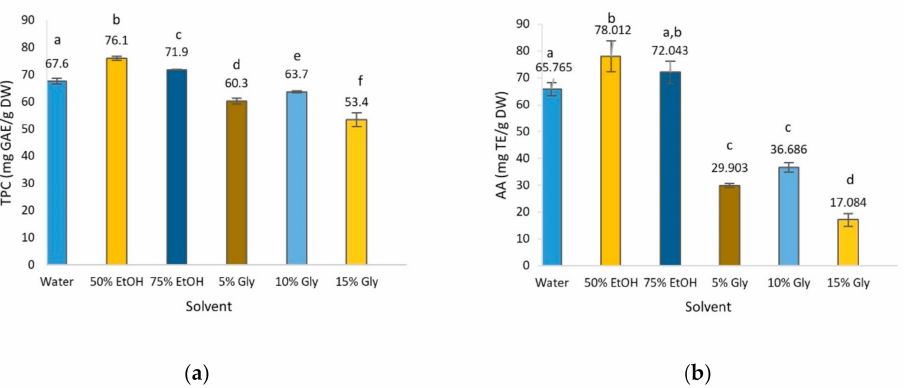
Figure 1. Total phenol content (TPC) ( a ) and antioxidant activity (AA) ( b ) of olive leaf extract obtained by Soxhlet extraction as a function of solvent. Different letters above the bars represent significant differences at p <